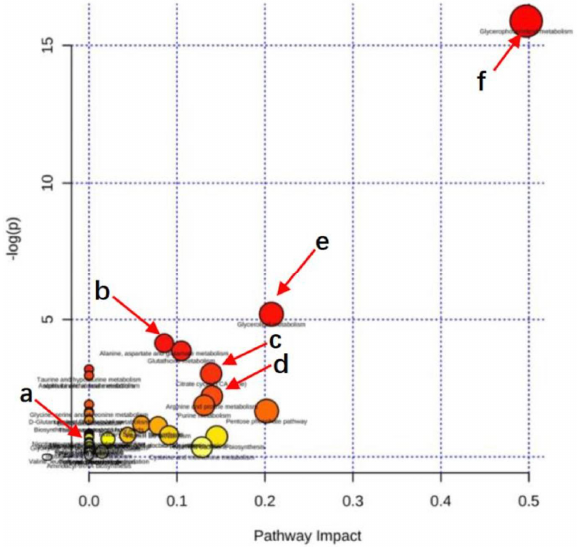
Figure 9. Pathway enrichment. Summary of pathway analysis of significantly reversed metabolites between rats in MG and SBS-treated rats. Rich factor and KEGG pathway were plotted on the x- and y-axis, respectively. The larger the dot, the greater the number of metabolites that were enriched in the pathway. The darker the dot color, the more significant the enrichment. ( a ) Nicotinate and nic- otinamide metabolism. ( b ) Alanine, aspartate, and glutamate metabolism. ( c ) Citrate cycle (TCA cycle). ( d ) Arginine-proline metabolism. ( e ) Glycerophospholipid metabolism. ( f ) Glycerolipid me- tabolism.